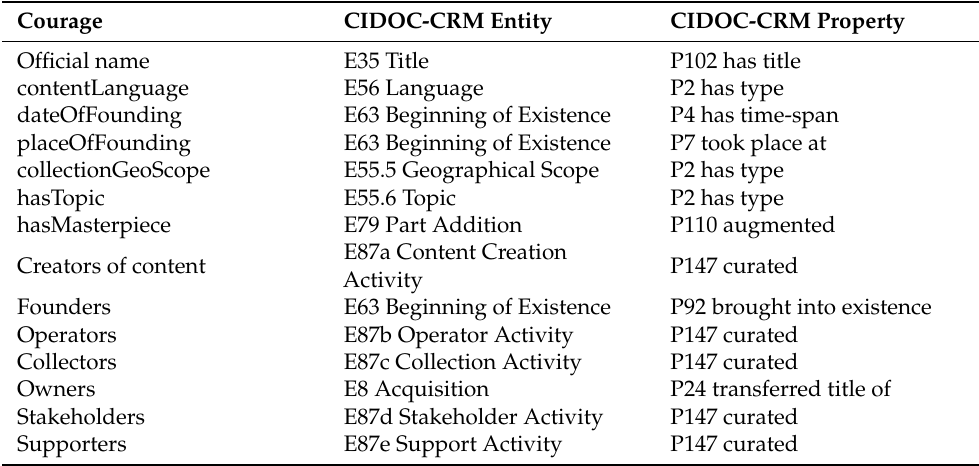
Table 3. COURAGE collection entity representation in CIDOC-CRM.